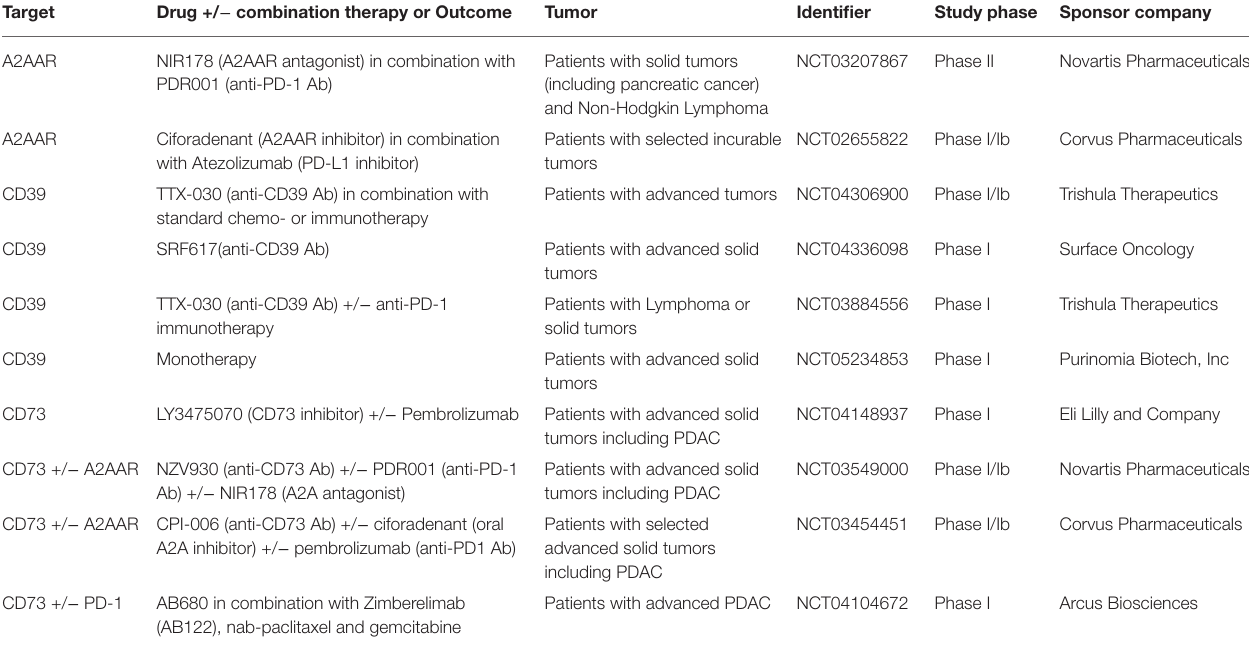
TABLE 1 | Clinical trials evaluating the potential use of purinergic mediators as targets for hepatopancreatobiliary tumors. Target Drug +/ − combination therapy or